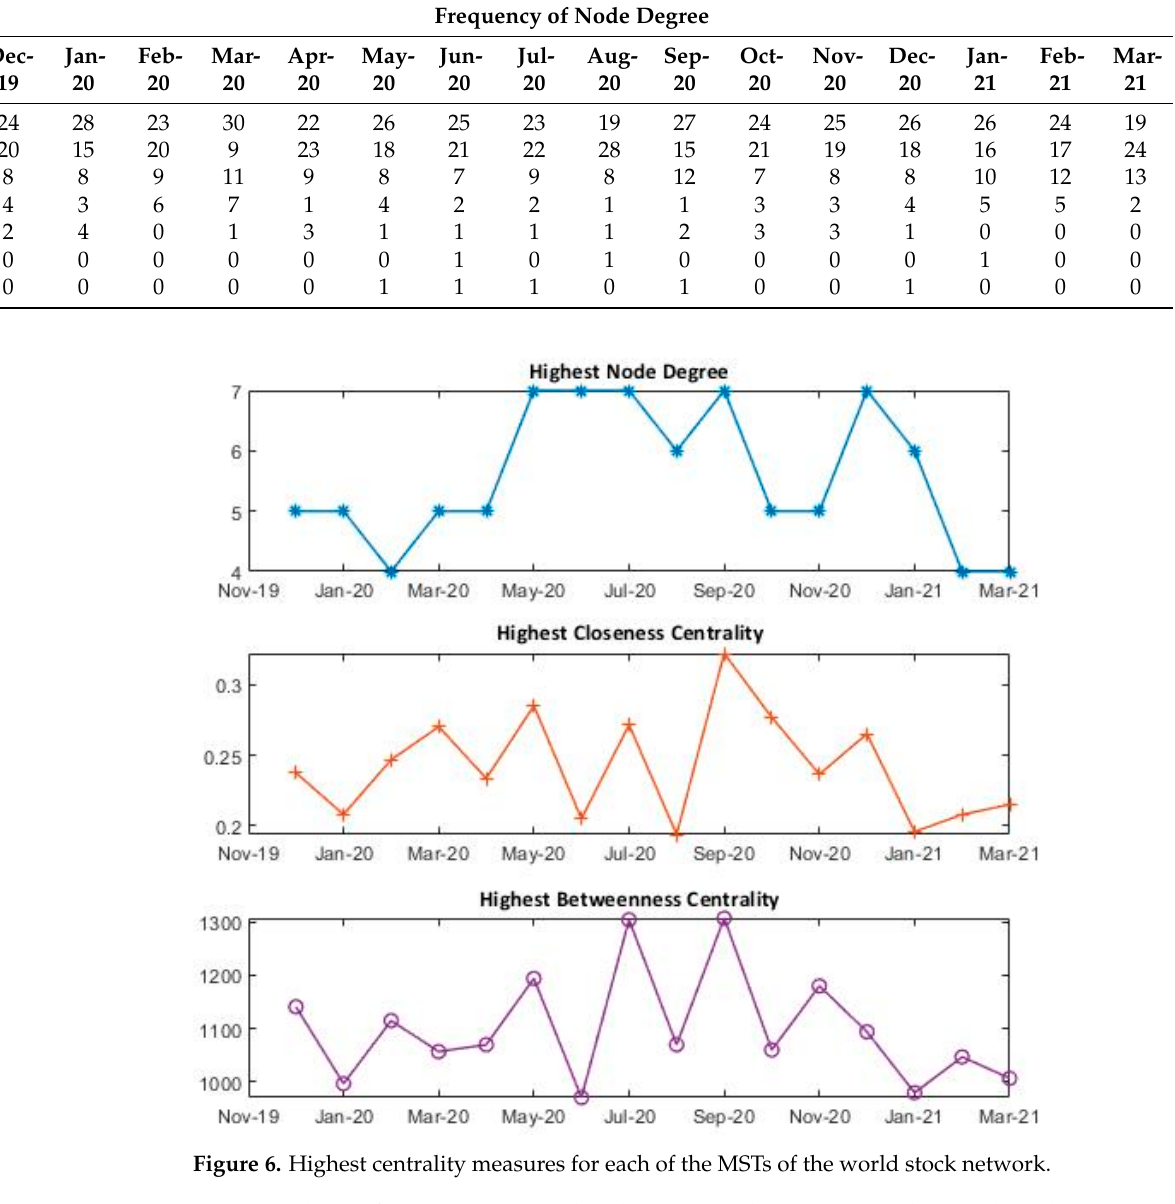
Table 1. Frequency of node degree distribution of time-varying MSTs.